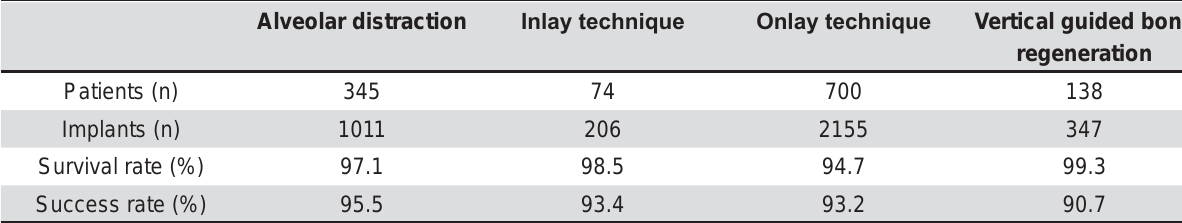
were treated with a combination of onlay and inlay techniques. Three different donor materials for the